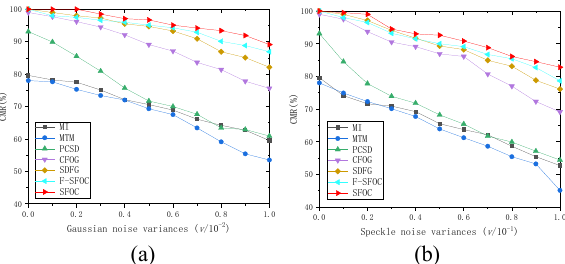
Figure 7. Average CMRs of different methods versus various noise. (a) Average CMRs of different methods versus various Gaussian white noise. (b) Average CMRs of different methods versus various speckle noise.